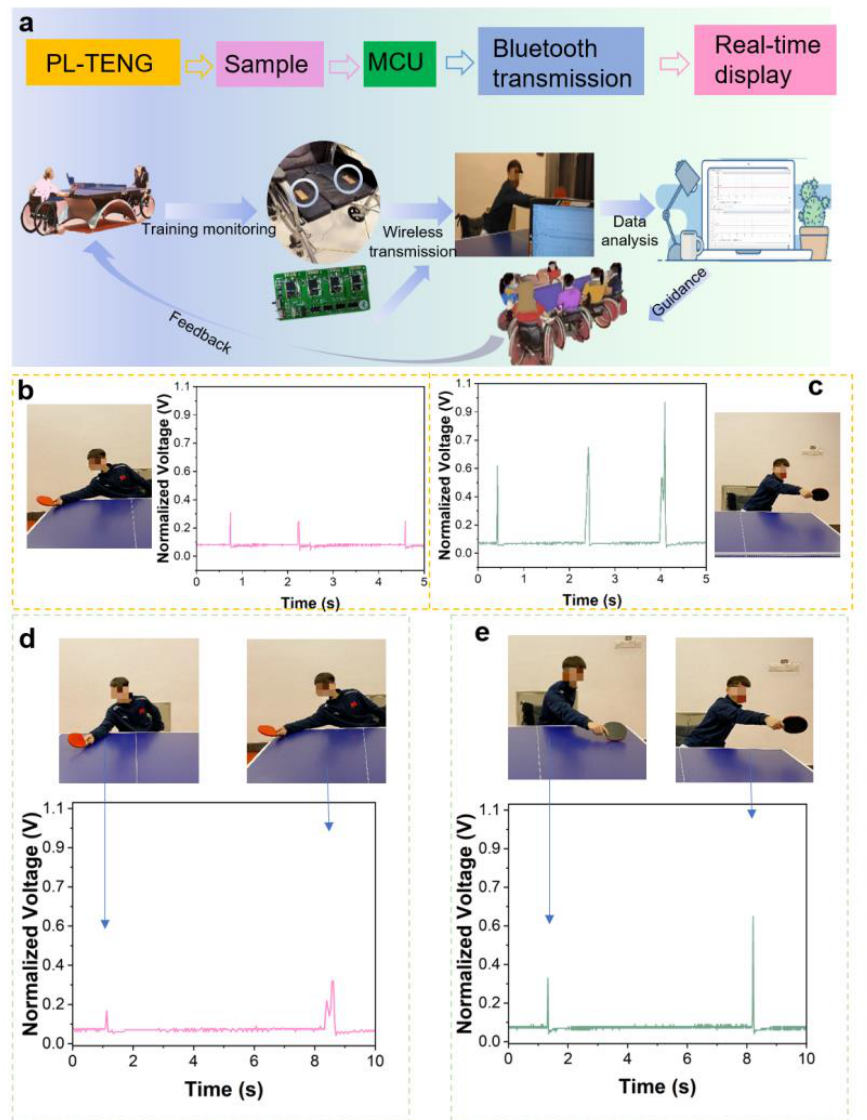
Figure 5. ( a ) Using the PL-TENG wireless transmission of motion data and guidance analysis. ( b ) Output voltage signals of three forehand short balls. ( c ) Output voltage signals of three backhand short balls. ( d ) Comparison of the PL-TENG output voltages when hitting forehand balls at different distances. ( e ) Comparison of the PL-TENG output voltage when hitting backhand balls at different distances.